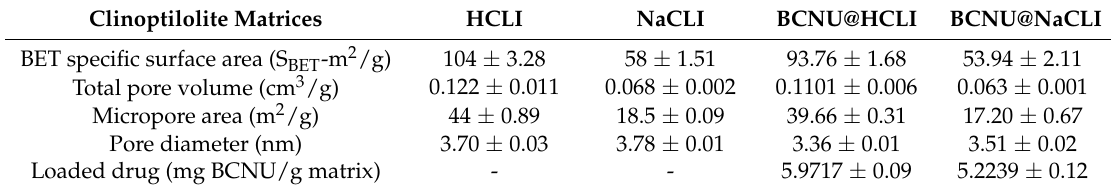
Table 1. Porous properties and drug content of modified delivery clinoptilolite-based systems. Clinoptilolite Matrices